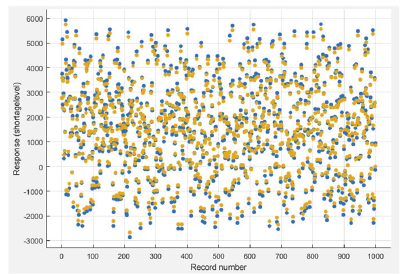
Fig. 11. Graphical comparisons of algorithms (raw material inventory model)